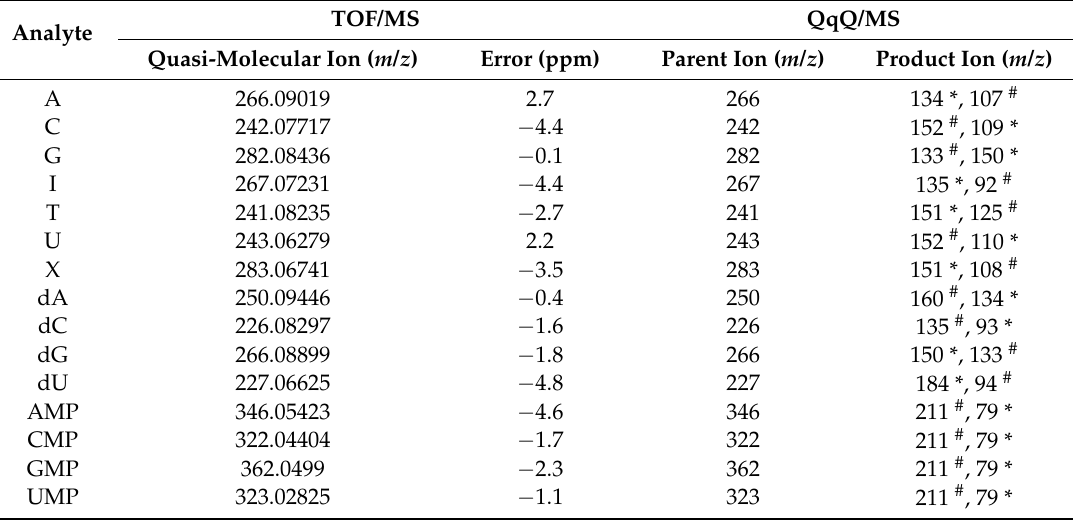
Table 1. Mass spectrometric parameters of 15 nucleic acid constituents in the negative ion-scan mode.